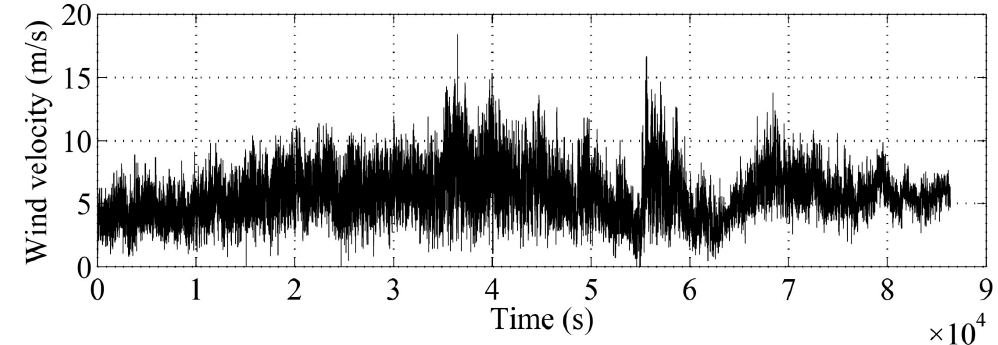
Figure 2. Wind velocity monitored by the anemoscope.